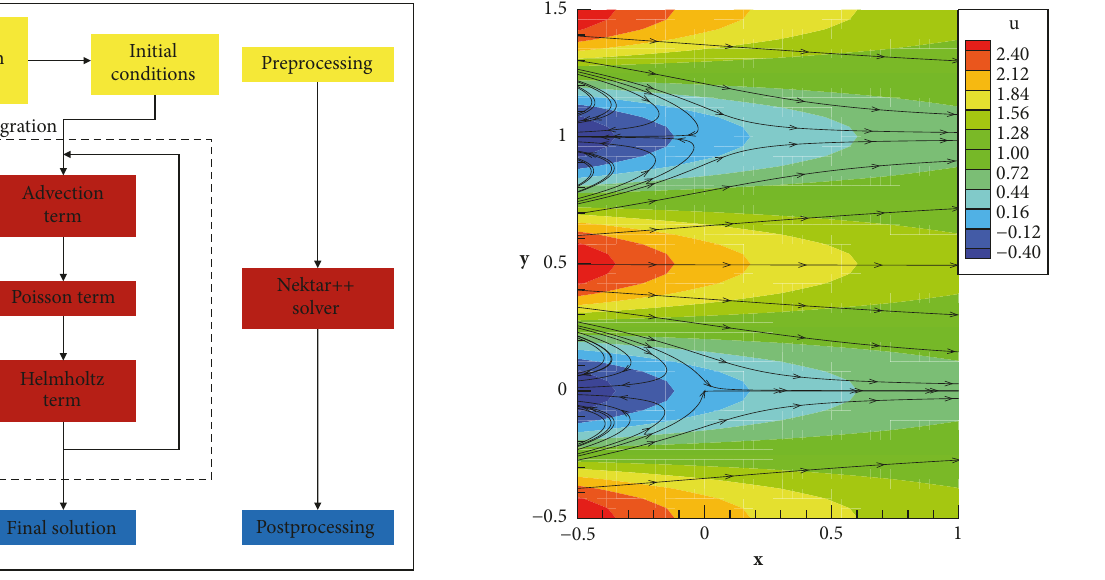
Figure 3: The block diagram of the incompressible Navier-Stokes solution algorithm.